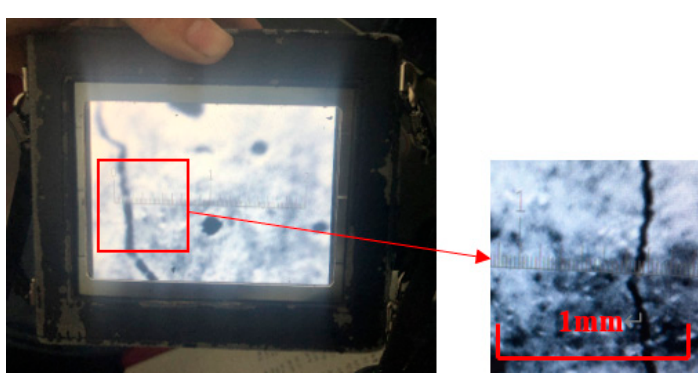
Figure 5. Crack width measurement.